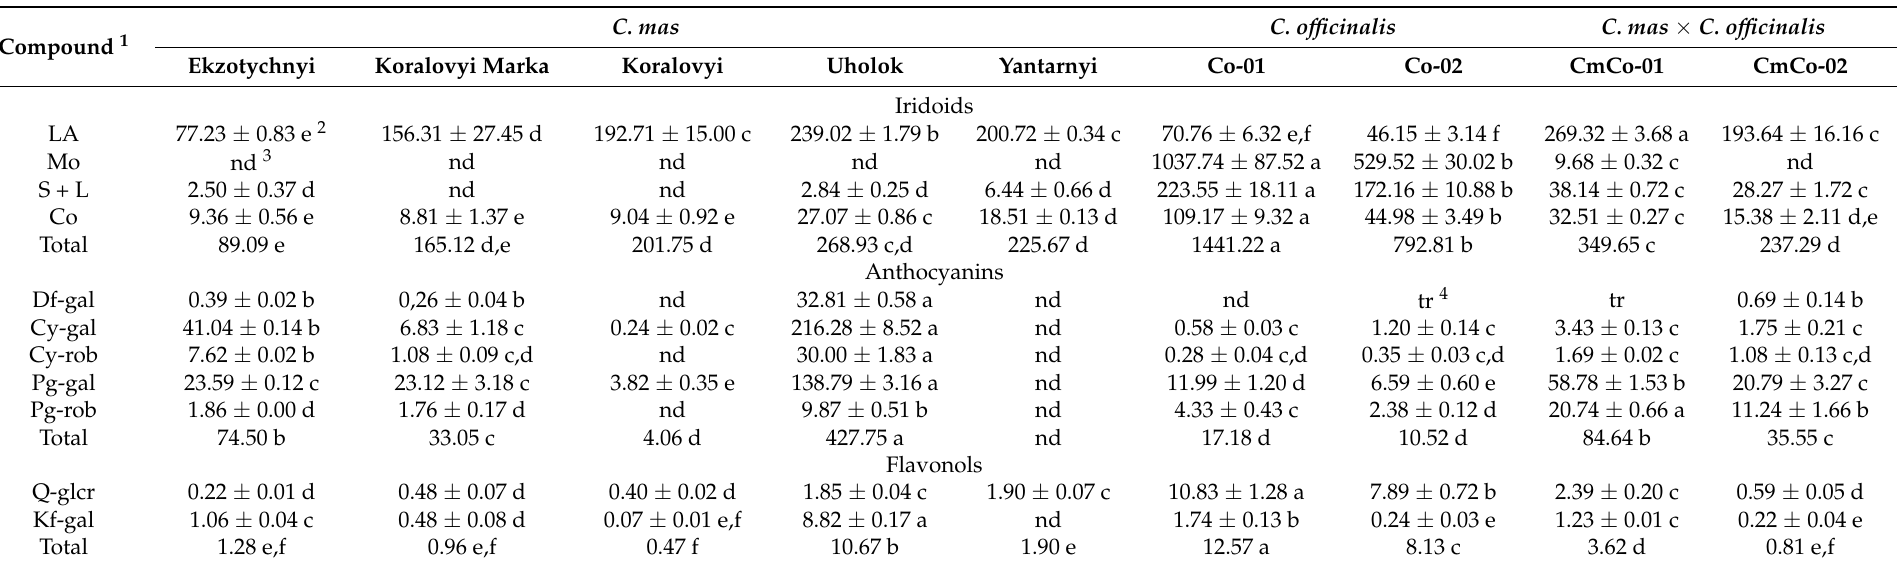
Table 1. Iridoids, anthocyanins, and flavonols content (mg/100 g FW) in Cornus mas L., C. officinalis Siebold & Zucc., and C. mas × C. officinalis